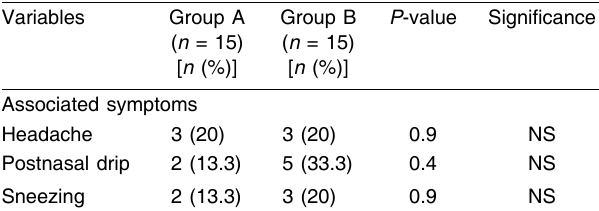
Table 4 Comparison of associated symptoms in both groups postoperatively